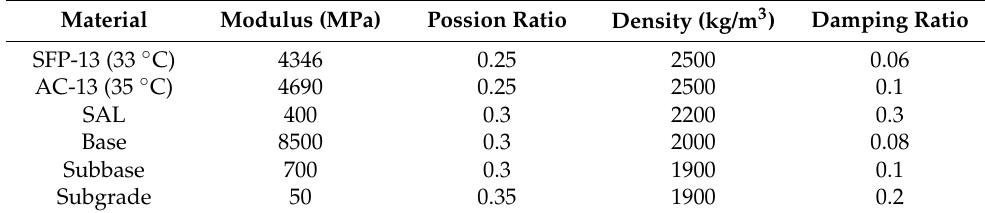
Figure 6. The structure and dimensions of semi-flexible ART pavement. Table 2. The material parameters used in the model.